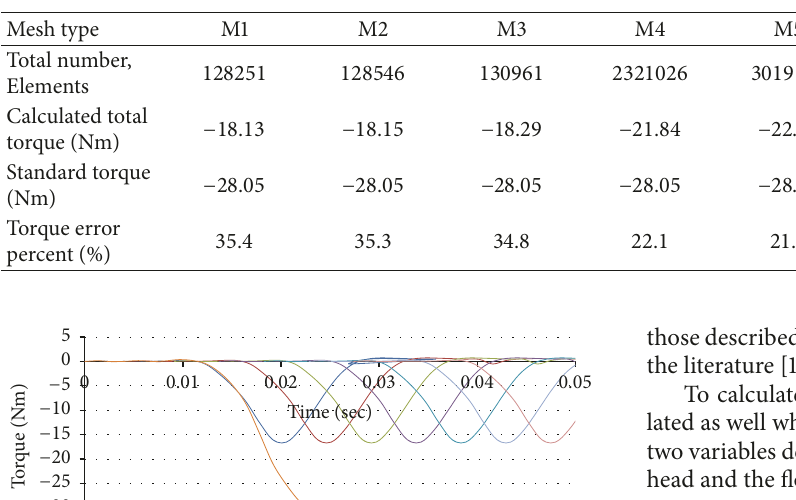
Table 10: Mesh dependent test analyzed for PCD = 400 mm.